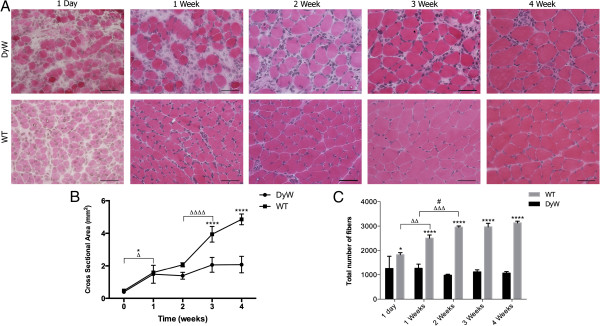
Qualitative and quantitative analysis of hematoxylin and eosin–stained tibialis anterior muscle sections show pathology as early as 1 week of age. (A) Qualitative histological analyses of tibialis anterior (TA) muscles show pathogenesis beginning as early as 1 day of age in Lama2DyW (DyW) mice. These muscles have large interstitial spaces filled with infiltrating mononucleated cells. Additionally, the muscles tend to lack both consistent fiber sizes and a hierarchical organization of connective tissue. (B) Cross-sectional area measurements show limited growth in DyW mice compared to wild-type (WT) mice during the first 4 weeks of life. WT mice have significantly larger muscle cross-sections at weeks 3 and 4 compared to DyW mice (P < 0.0001 by two-way analysis of variance (ANOVA) (n = 3 to 5)). (C) Counts of the total number of muscle fibers indicate that, as early as postnatal day 1, DyW mice already had a decreased number of muscle cells and that this number increased during development. At all time points, DyW mice had significantly fewer myofibers than their WT counterparts (P < 0.0001 by two-way ANOVA (n = 3 to 5). Note that, though the cross-sectional area does not indicate a diference at week 1, pathology is reflected in the fiber count. Asterisks indicate statistical significance between age-matched DyW and WT animals, hash tags indicate significant changes within the DyW group and Deltas indicate significant changes within the WT group. *P < 0.05, **P < 0.01, ***P < 0.001 and ****P < 0.0001. These statistical representations also apply other symbols (Δ, #). Bar = 50 μm.